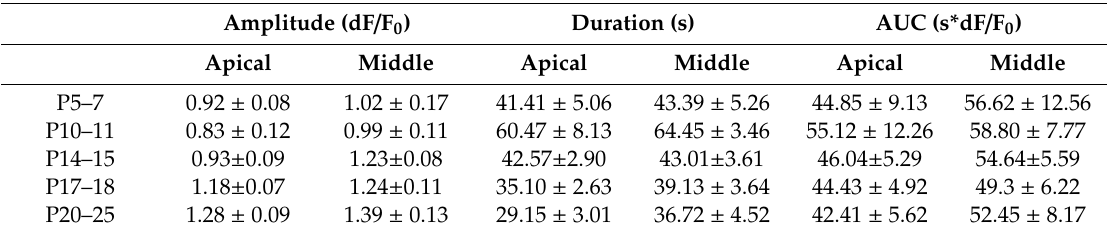
Figure 3. Exogenous ATP (100 µ M in perfusion) evoked developmental state- and tonotopy-dependent Ca 2 + transients in Deiters’ cells. Individual responses (grey) recorded in the phalangeal processes ( A , red) and the somas ( B , blue) of Deiters’ cells with their average (wider line) and ± SEM (dashed line) traces in the apical turn at three di ff erent developmental states. The bar graphs show the magnitudes of the amplitudes of all measured cell responses (black dots) and their mean ± SEM in the processes ( C ) and somas ( D ) in the apical (darker symbols) and middle (lighter symbols) cochlear turns. Note that the maturation- and turn di ff erence-dependent gradual increase in the processes and the tendency of decrease in the somas from P10–11, which is the onset of mouse hearing. A number of experiments are in parenthesis. Respective p valuess, showing the significance of age or tonotopy are written in italics. Details of statistical analysis are given in the Materials and Methods. Table 3. Magnitude and kinetic characteristics of ATP (100 µ M) induced Ca 2 + transients in the phalangeal process of Deiters’ cells (mean ±